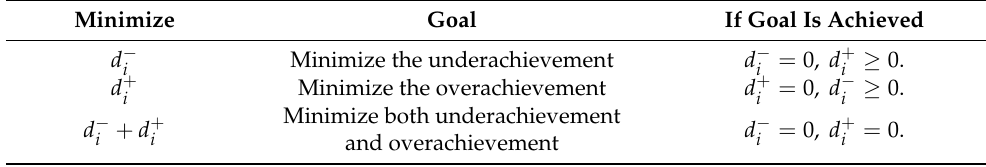
Table 2. Options for achieving a